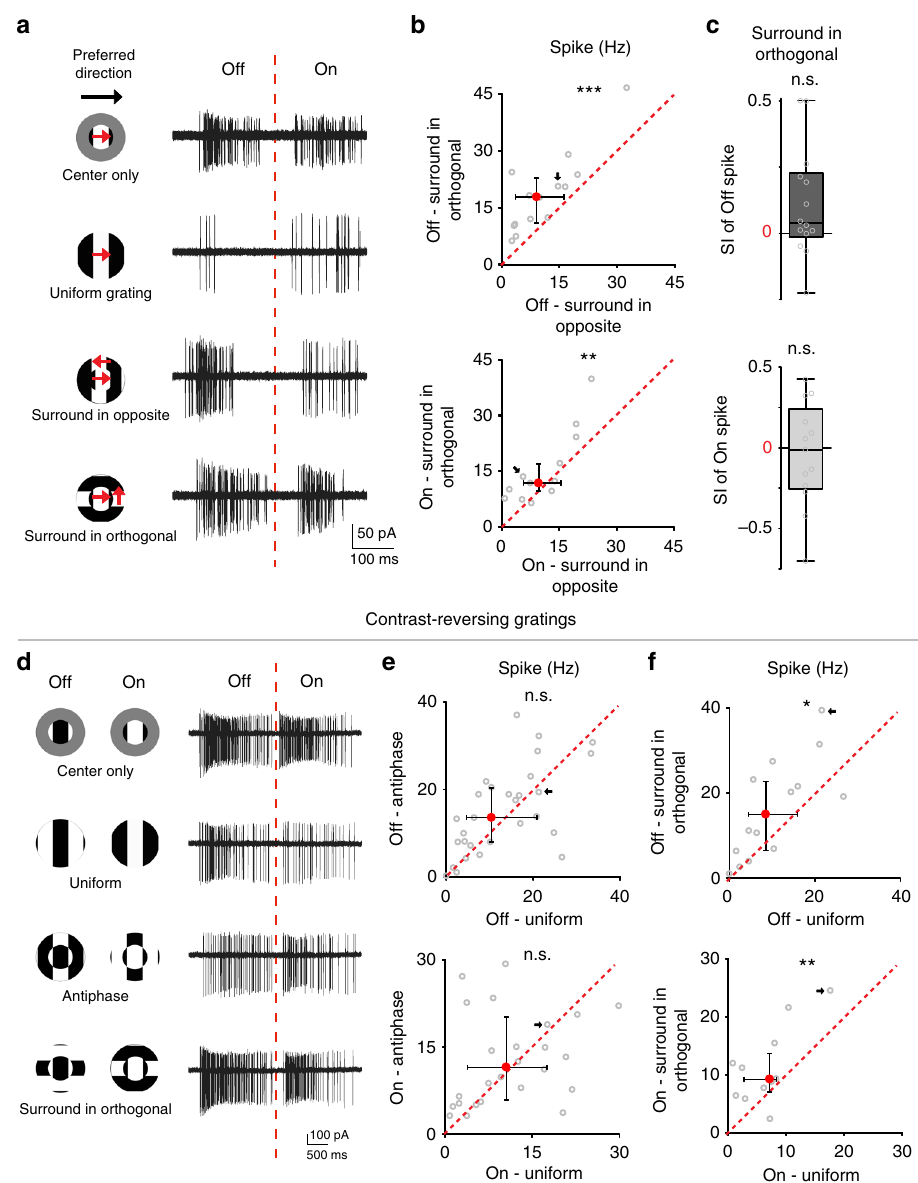
Fig. 9 Contextual modulation of pDSGCs is sensitive to the relative orientation of center and surround contours. a Example spike traces of a pDSGC from a control mouse evoked by the visual stimuli shown on the left. The red dashed line shows the boundary of the Off and On responses. b Comparison of pDSGC fi ring rate during surround-in-orthogonal versus surround-in-opposite gratings, pairwise comparison was performed using Wilcoxon signed-rank test. Off response: n = 14 cells from 8 mice, *** p < 0.001; On response: n = 13 cells from 7 mice, ** p = 0.0081. c Upper panel: SI of Off spike during surround-in-orthogonal: Wilcoxon signed-rank test was used to test whether the SI of surround-in-orthogonal is signi fi cantly higher than 0: p = 0.091. Lower panel: SI of On spike during surround-in-orthogonal: p = 0.32. The same sample groups as Fig. 8b. d-f Loose-patch recording of pDSGC under contrast-reversing stationary gratings. d Left: Schematics show the contrast-reversing stationary grating stimuli. Right: Spiking responses of an example pDSGC from a control mouse. Red dashed line labels the boundary of Off and On spiking. e Scatter plots compare pDSGC spike fi ring rate during uniform contrast-reversing gratings and antiphase contrast-reversing gratings. Off response: n = 29 cells from 7 mice, p = 0.14; On response: n = 26 cells from 7 mice, p = 0.70. f Same as e , but comparing pDSGC spike fi ring rate during uniform contrast-reversing gratings versus surround-in-orthogonal contrast- reversing gratings. Off response: n = 14 cells from 4 mice, * p = 0.020; On response: n = 11 cells from 4 mice, ** p =